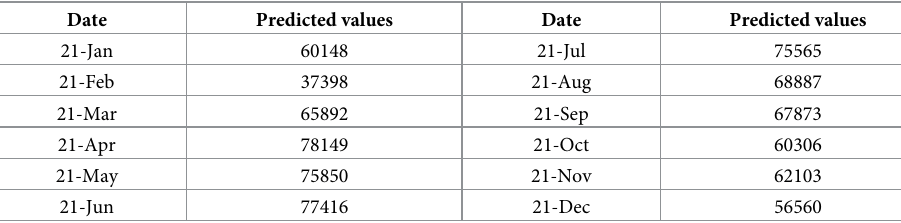
Table 6. Prediction of TB cases in mainland China from January to December in